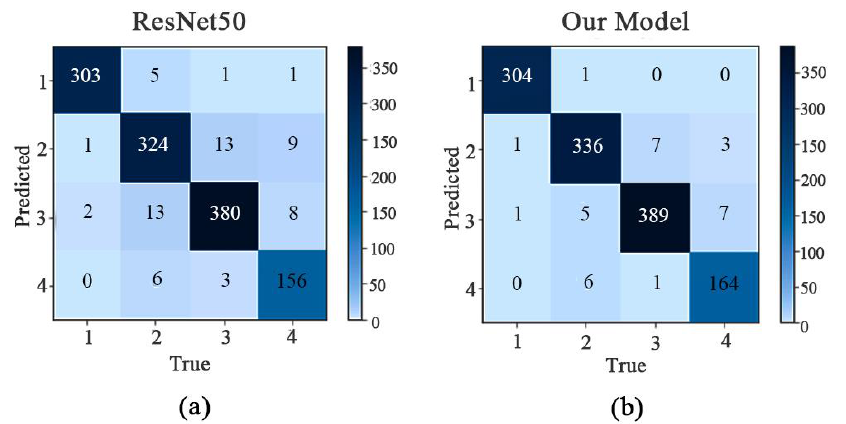
Figure 9. Confusion matrix before and after the model improvement. ( a ) ResNet50 confusion matrix; ( b ) our model confusion matrix. Note: 1 is principal; 2 is first-class; 3 is second-class; 4 is inferior. The x-axis is the real category, and the y-axis is the predicted category.